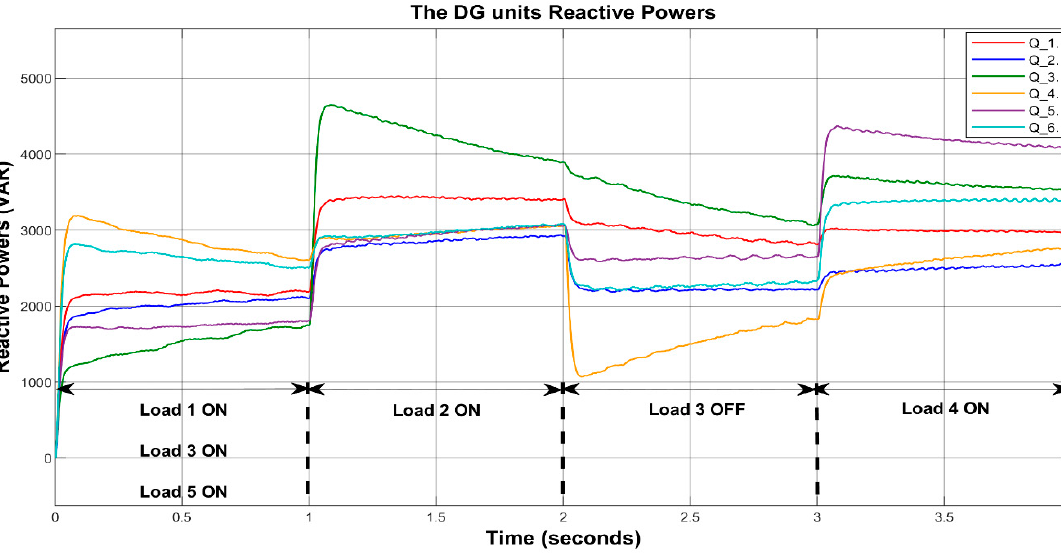
Figure 12. The DG units’ of phase a of output current for Case 1.